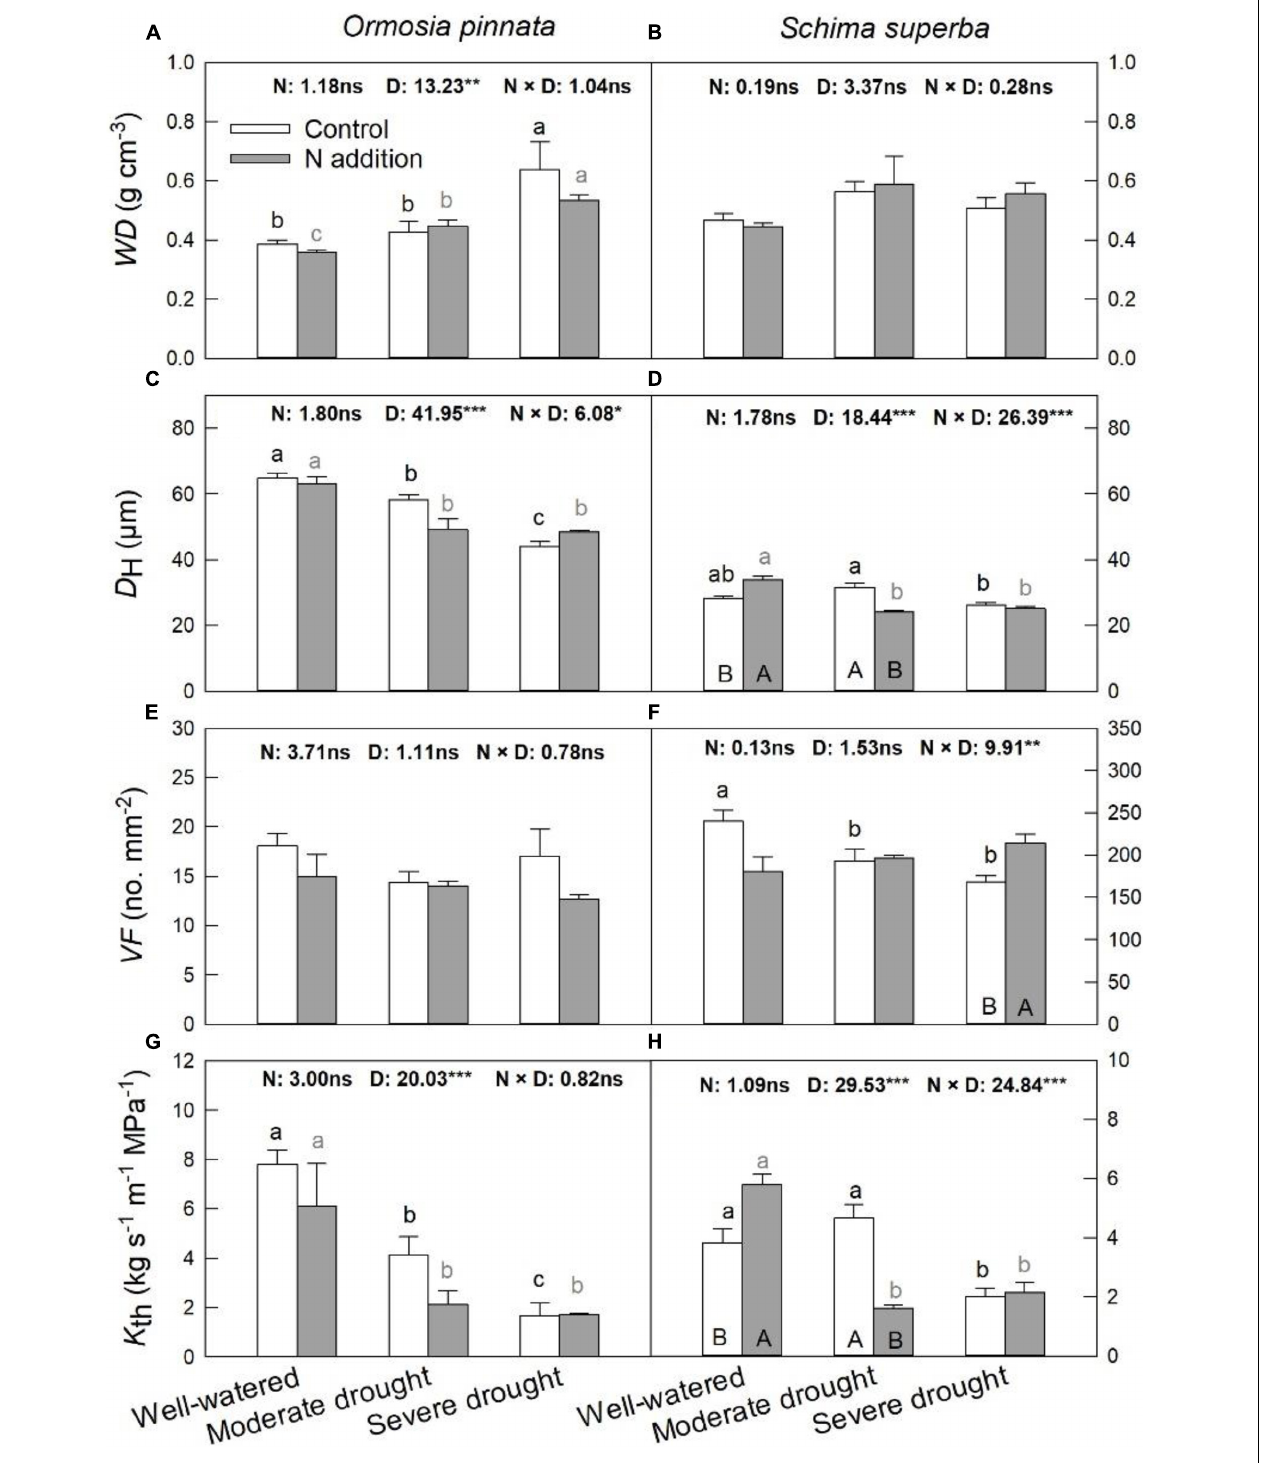
FIGURE 4 | Responses of sapwood density ( WD ; A,B ), mean hydraulically weighted vessel diameter ( D H ; C,D ), vessel frequency ( VF ; E,F ), and theoretical hydraulic conductivity ( K th ; G,H ) of O. pinnata and S. superba to different watering and N addition treatments. Bars show means ± SE ( n = 3). Different lowercase letters above bars indicate significant differences among three watering regimes within each N addition rate. Different capitalized letters below bars indicate significant differences between control and N addition within each watering regime. F -values of the two-way ANOVA of nitrogen (N), drought (D), and their interactions (N × D) are indicated. * P < 0.05; ** P < 0.01; *** P < 0.001; ns, not significant.